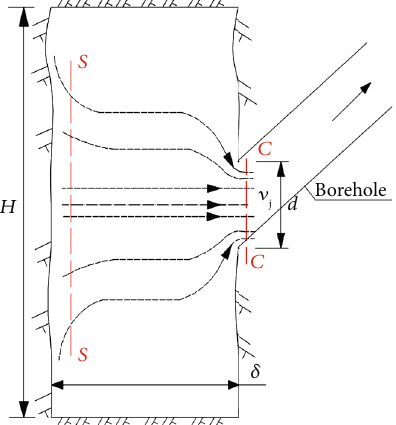
Figure 5: Sketch map of the fl ow at the junction from a wide fracture not penetrated by a